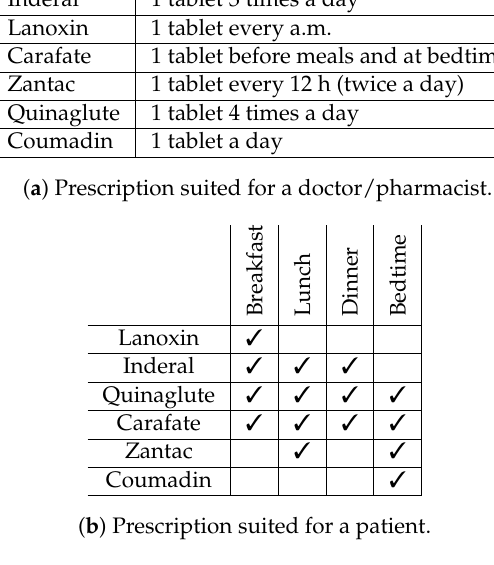
Figure 2. Two isomorphic views organized for different